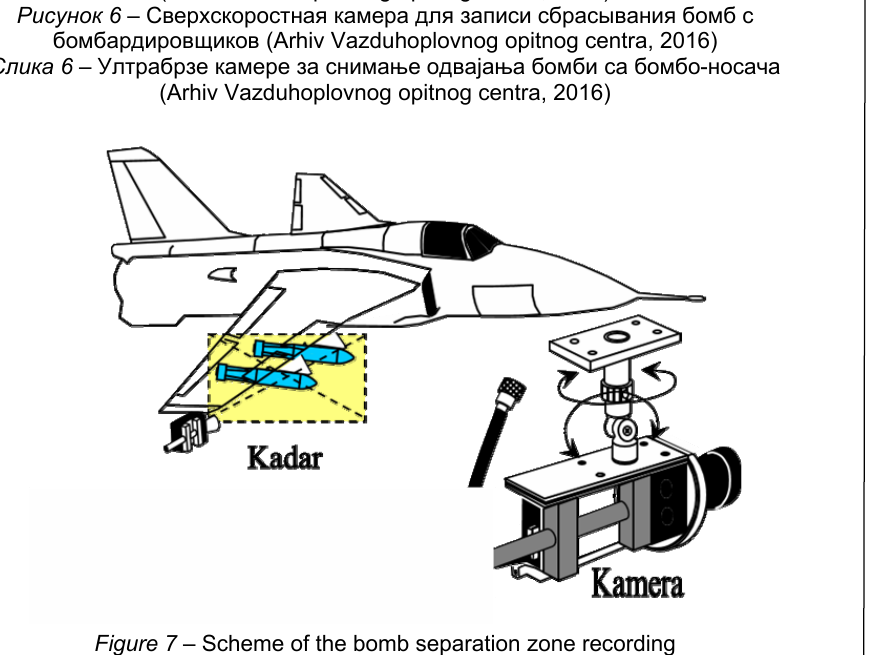
Figure 7 – Scheme of the bomb separation zone